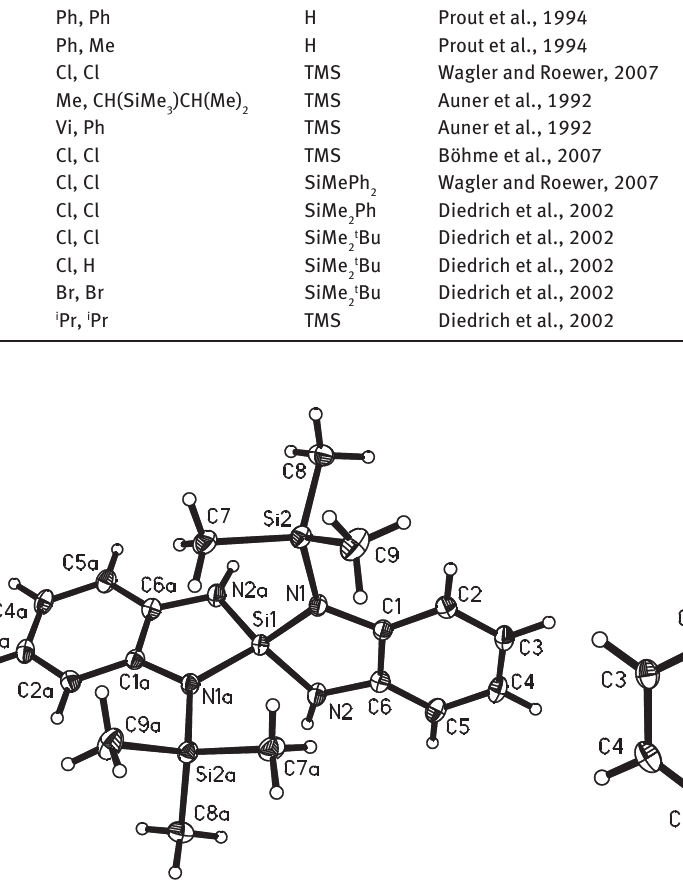
Figure 3: Molecular structure of 2b-TMS2 including numbering scheme. The thermal displacement ellipsoids of the non-hydrogen atoms are drawn at the 50% probability level.